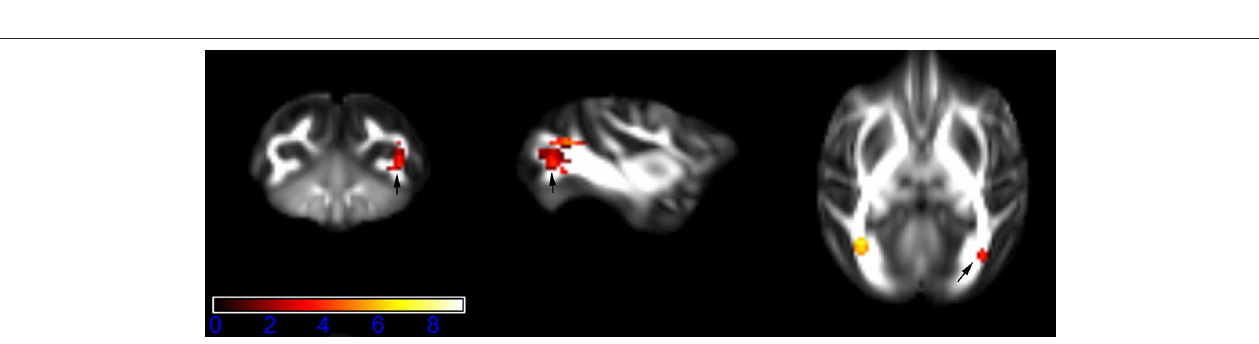
FIGURE 2 | Areas in posterior thalamic radiation (PTR, right side) with reduced fractional anisotropy values in the chronic ketamine exposure group compared to controls at p < 0.005 (in red; uncorrected). The anatomical underlay is DTI-based monkey brain image template (UWRMAC-DTI271) FA map with white matter atlas. Figure from left to right side is coronal view, sagittal view, and axial view of the images, respectively. The color bar represents the t